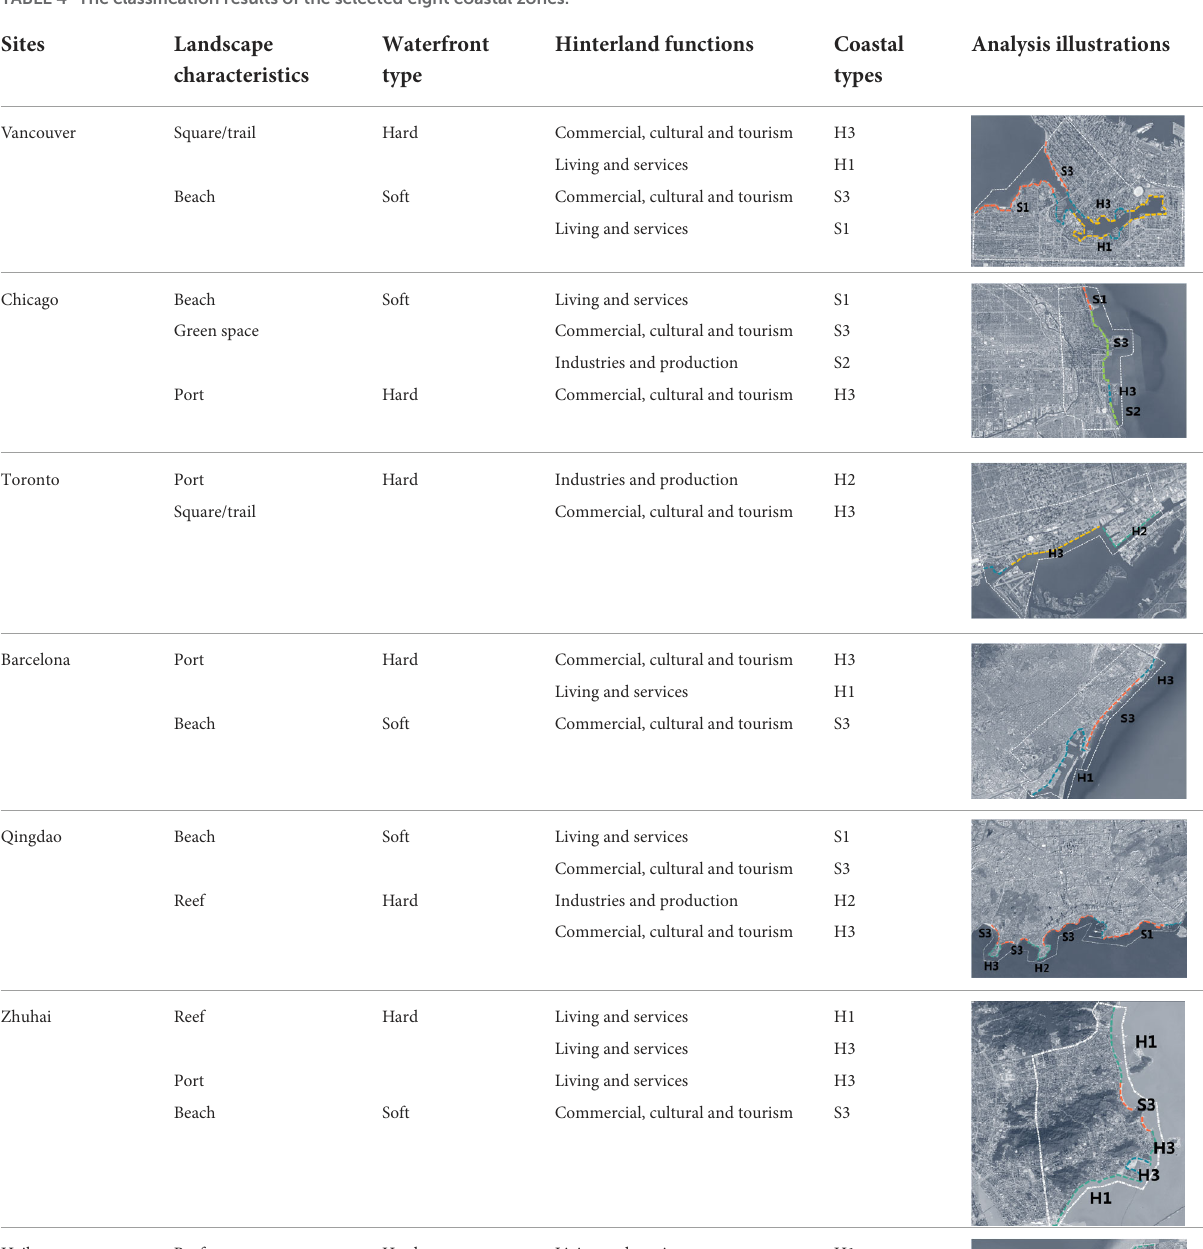
TABLE 4 The classification results of the selected eight coastal zones.